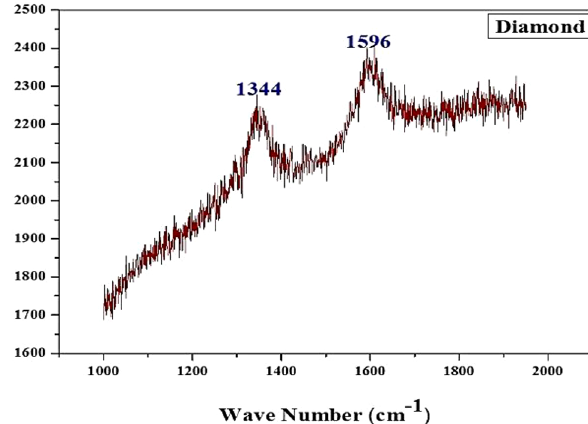
Fig. 4. Raman spectroscopy analysis of MCD insert.